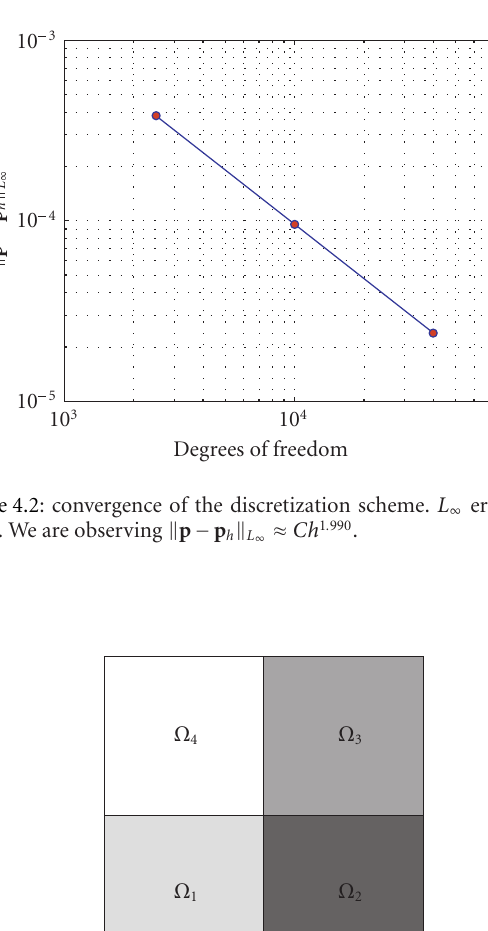
Figure 4.9 . Example 4.3: domain is divided into four subdomains Ω i , i = 1, ... ,4. The property (cid:2) in the subdomain Ω i is (cid:2) i .